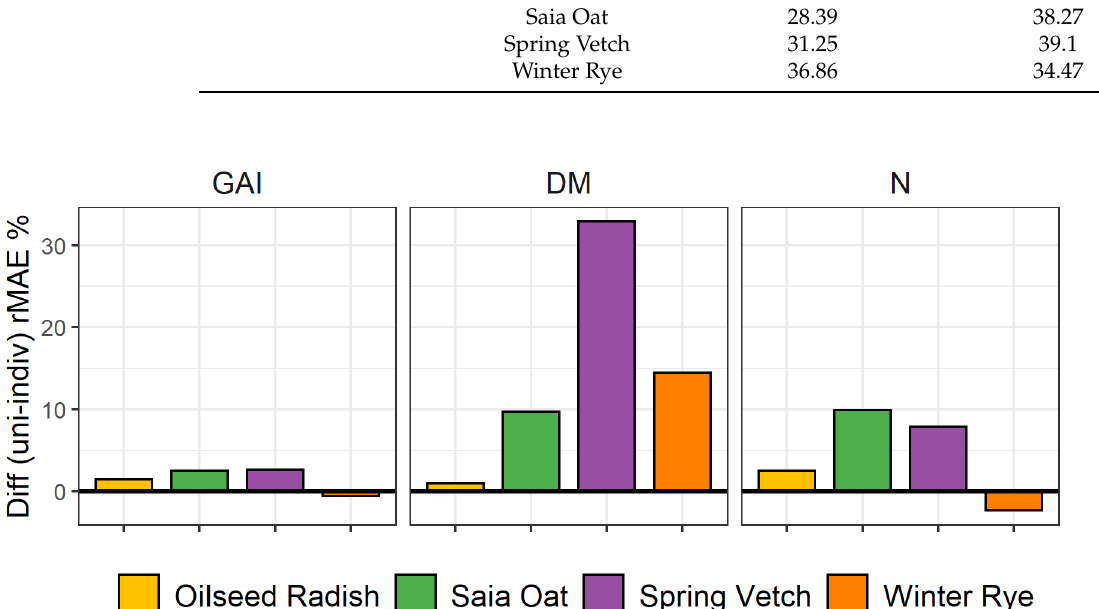
Figure 8. Comparison of the two model approaches ’ prediction performance for green area index (GAI), dry matter (DM), and N uptake (N) by relative mean absolute error (rMAE) (%). Illustrated is the difference (Diff) of the universal model (uni) calibrated with the sole cover crop data set and the species–individual models (indiv) of each separate cover crop (oilseed radish, saia oat, spring vetch, winter vetch, winter rye). Table 5. Comparison of the two model approaches ’ prediction performance (species – individual vs. universal models) for green area index (GAI), dry matter (DM), and N uptake (N) by relative mean absolute error (rMAE) (%) for each separate cover crop (oilseed radish, saia oat, spring vetch, winter rye).